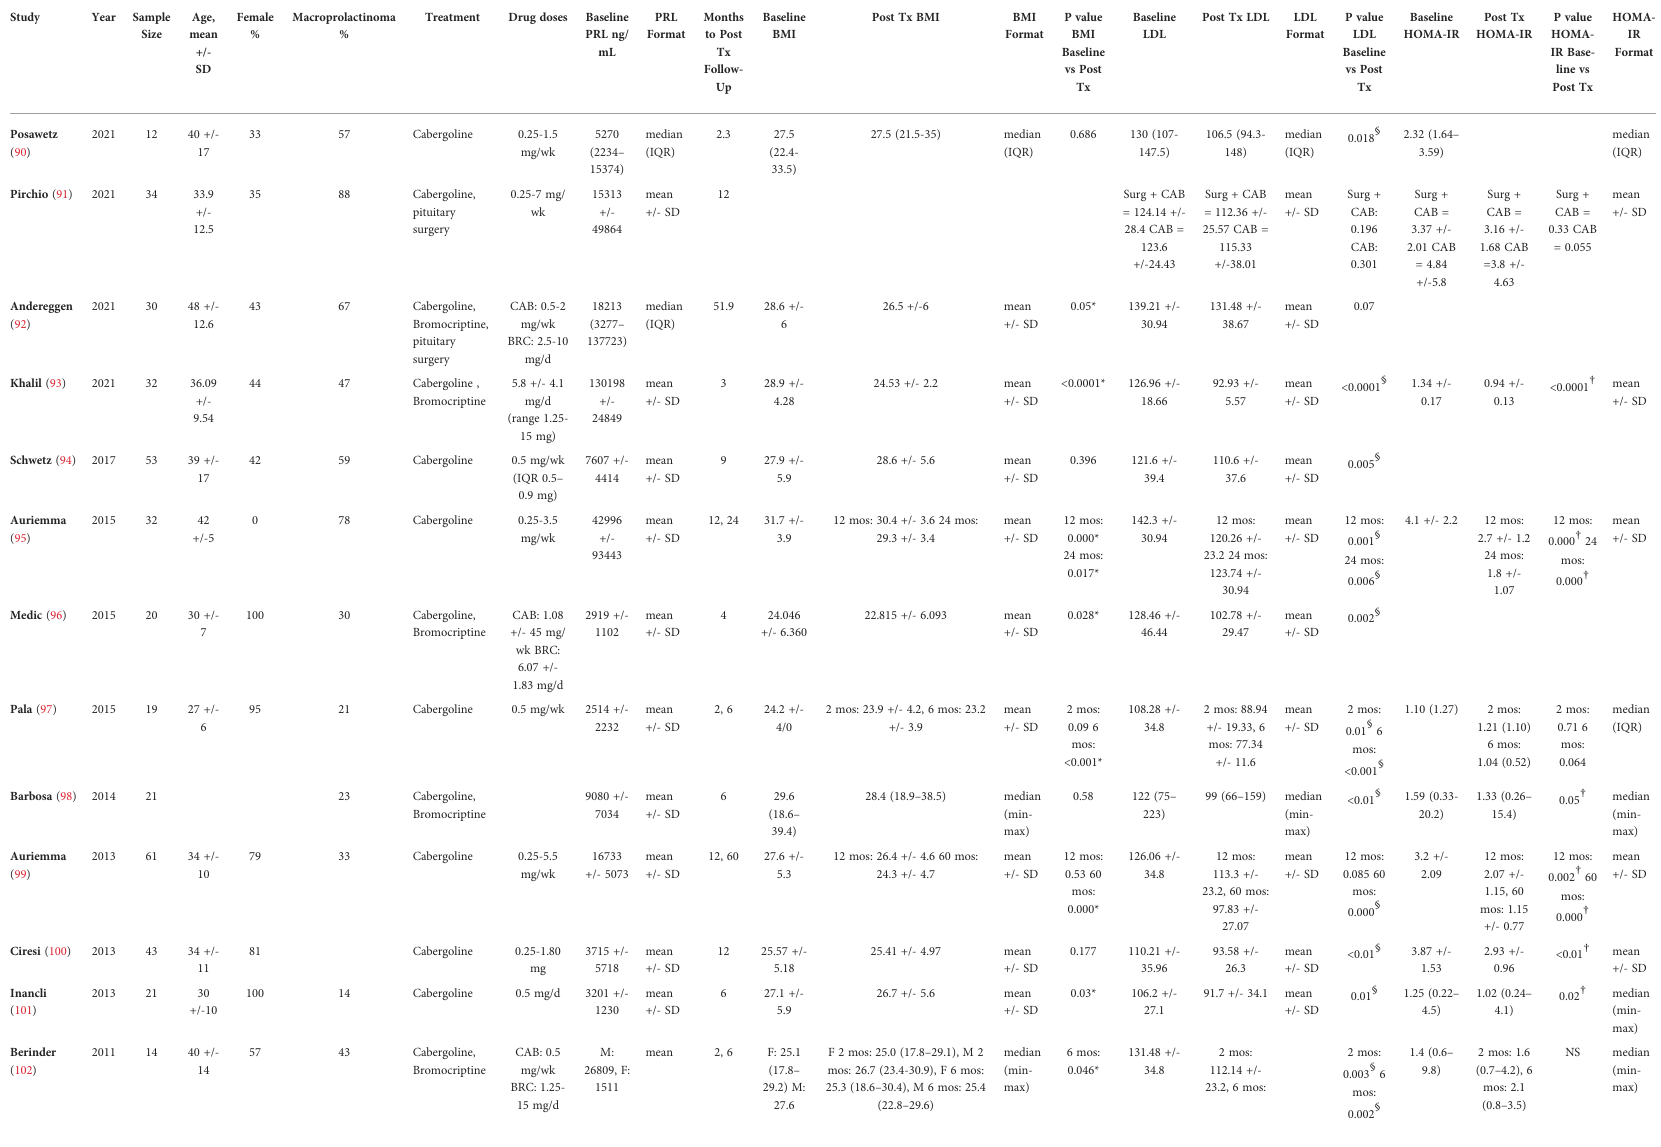
TABLE 2 Summary of recent studies evaluating the effects of dopamine agonists on metabolic parameters.